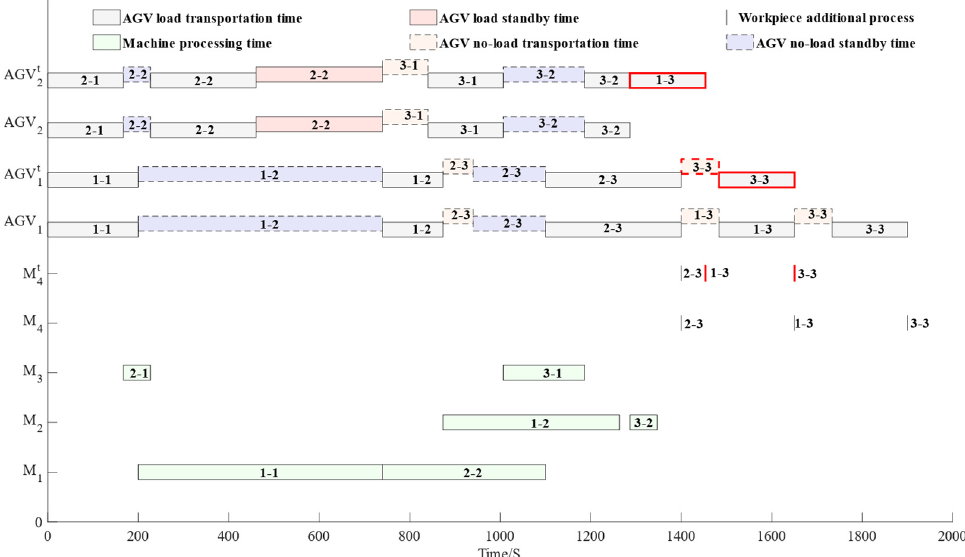
Figure 5. An example of Strategy 3.